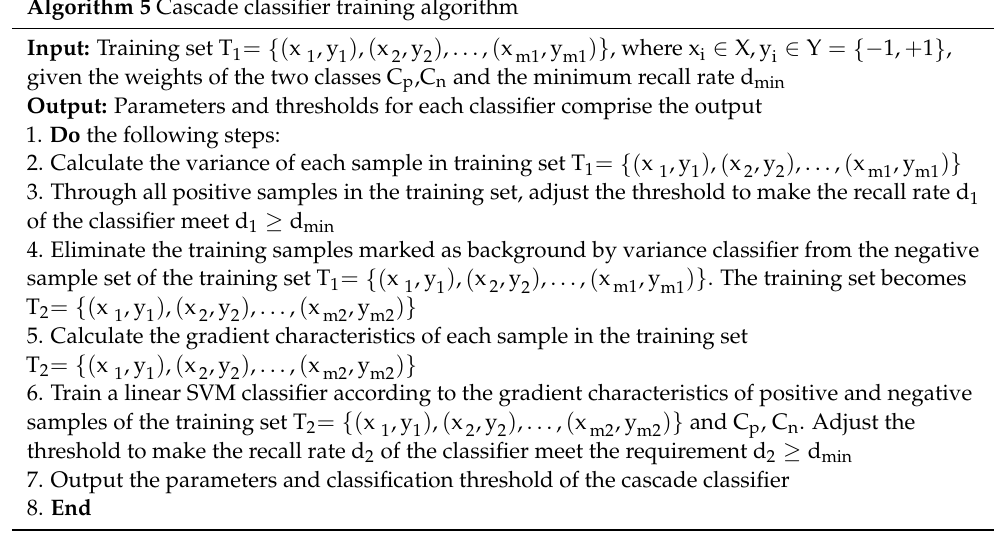
Algorithm 5 Cascade classifier training algorithm